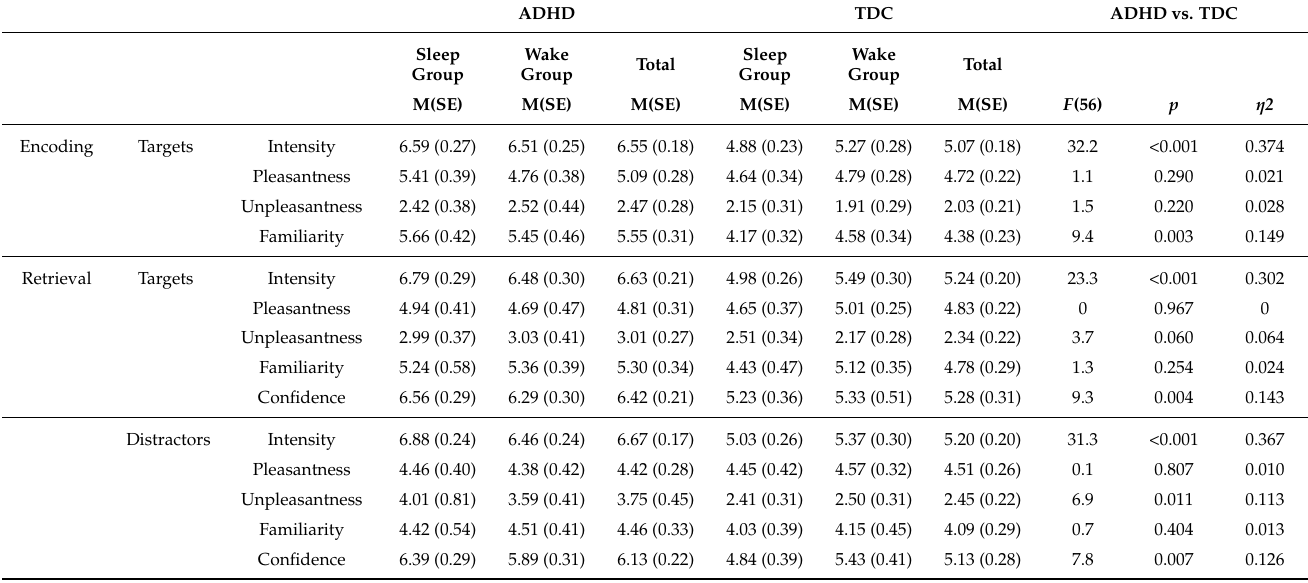
Table 5. Odor rating